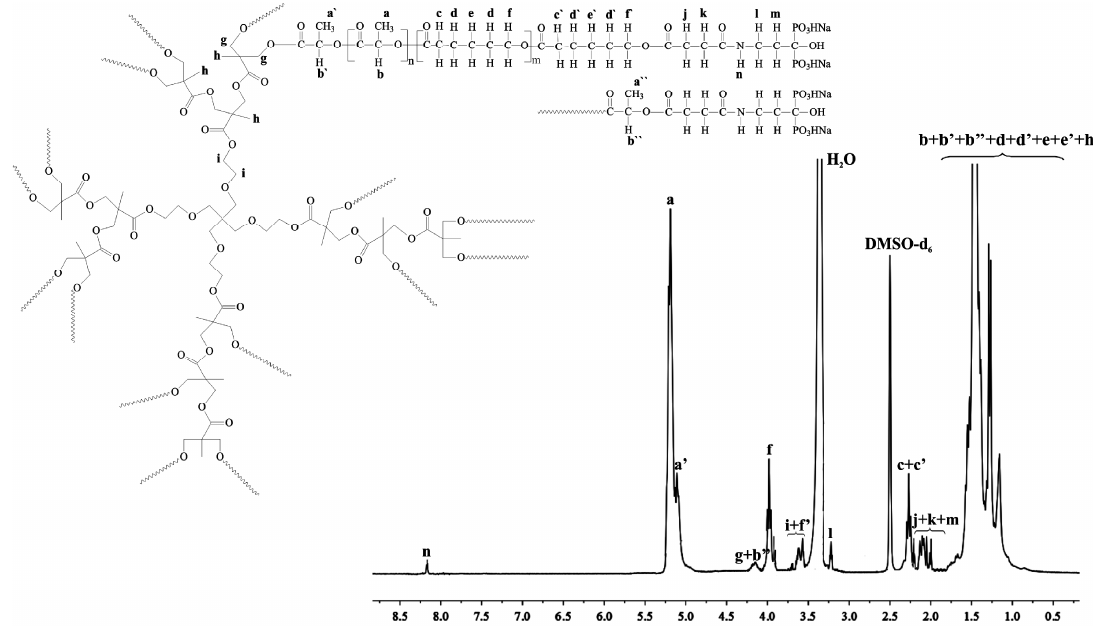
Figure 2. 1 H-NMR spectrum of bis-MPA-PLLA90-PKL38-PAM conjugate.